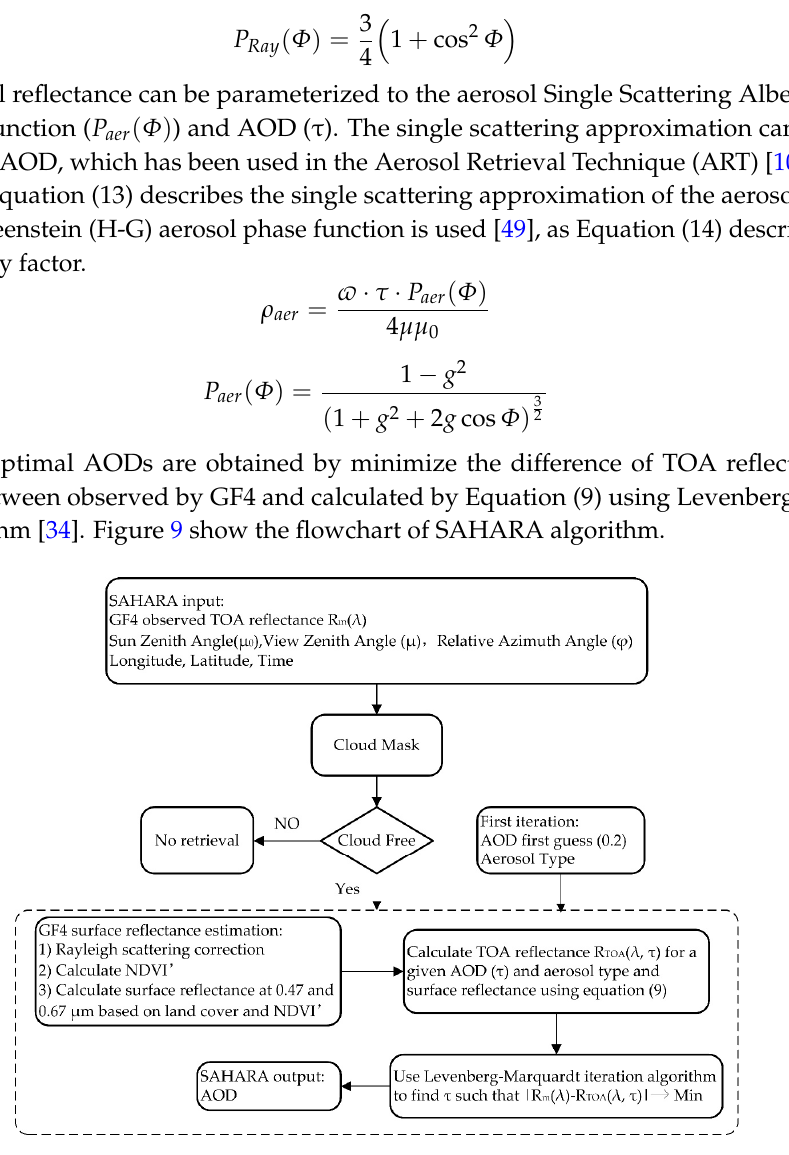
Figure 10. The comparison between SAHARA AOD using GF4 data and MODIS C6 combined AOD on 25 June 2016: ( a ) MODIS C6 combined AOD; ( b ) SAHARA 10 km AOD; ( c ) SAHARA 50 m AOD.